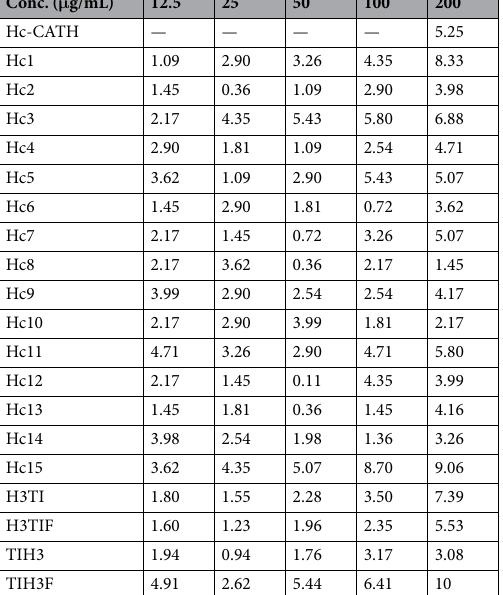
Table 2. Hemolysis rates of the peptides. Hemolysis rate of Hc-CATH, its truncated derivatives and four current hybrid peptides, “—” represents no assay.